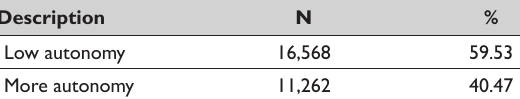
Table 1b: Level of autonomy Description N % Low autonomy More